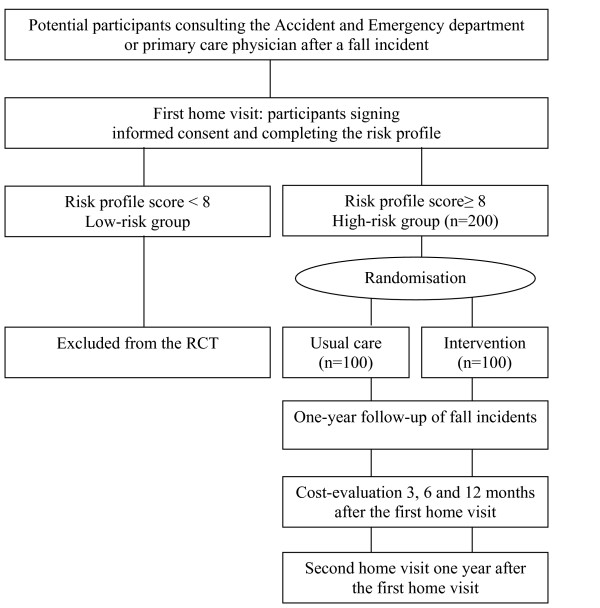
Design of the study.